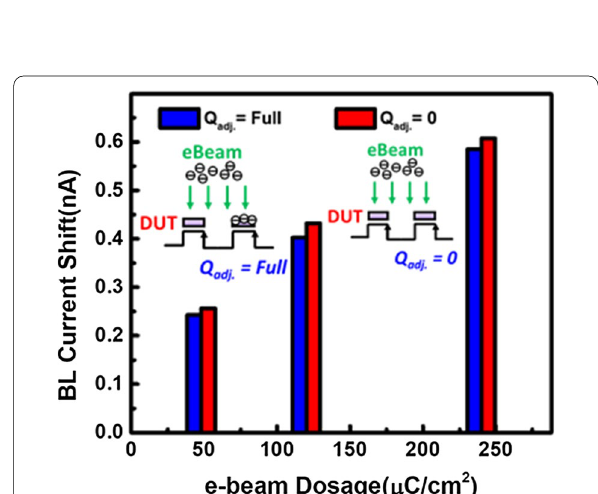
Fig. 9 The collection efficiency is found to be slightly reduced by fully stored floating gate on the adjacent cells, where some pattern interference effect is